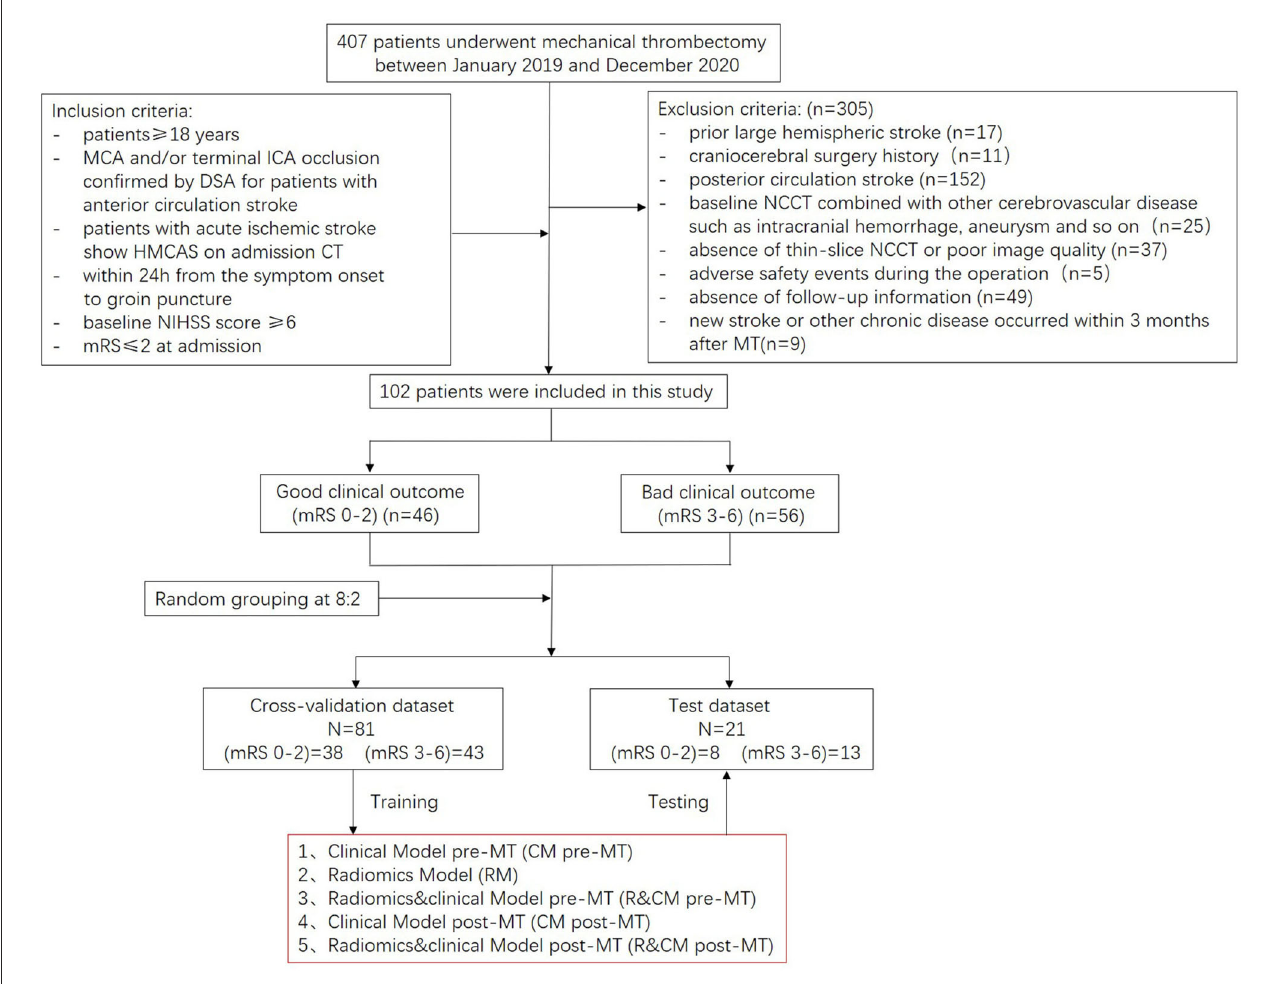
FIGURE1 The recruitment